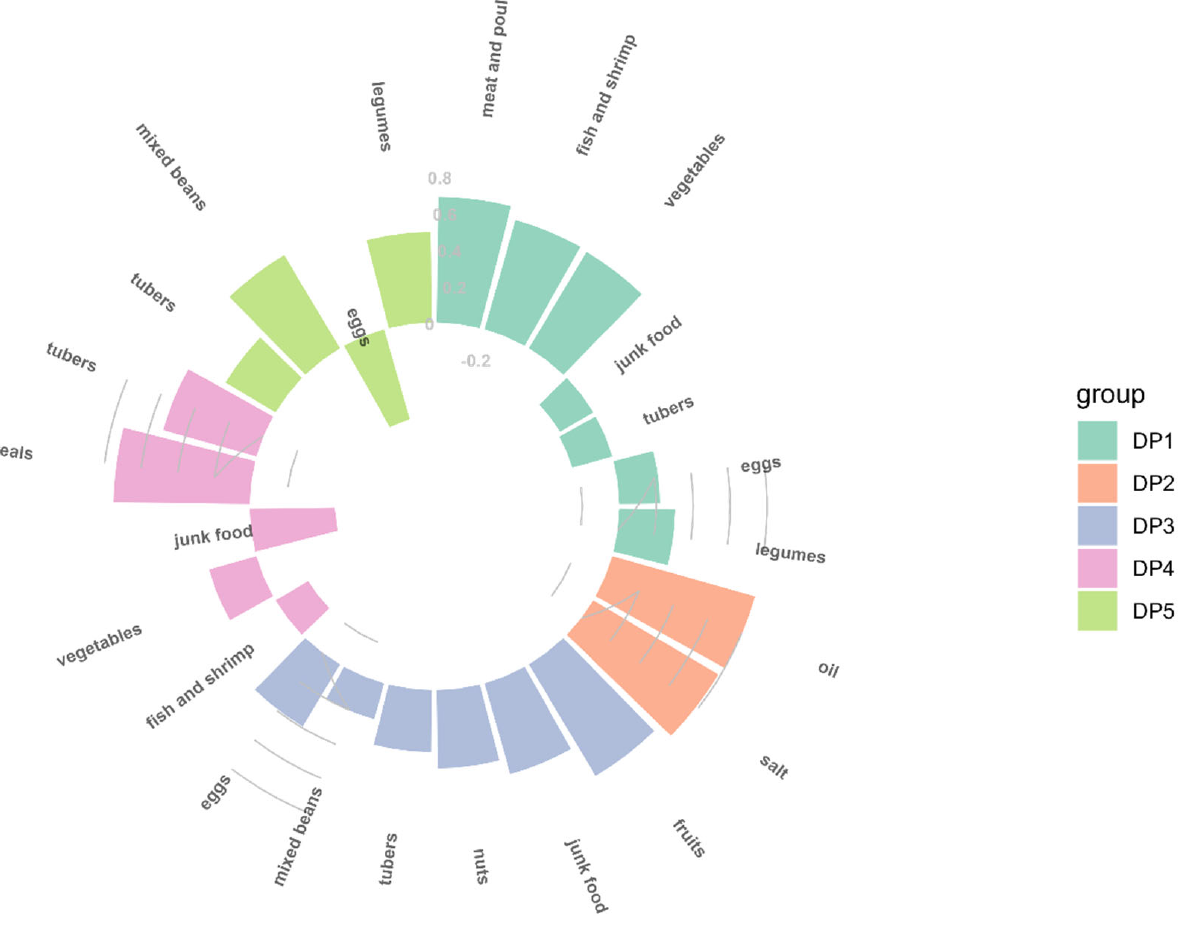
Table 2. Weighted percentages [ n (%)] of five DPs in children and adolescents aged 7–17 in 2016– 2017. Characteristics